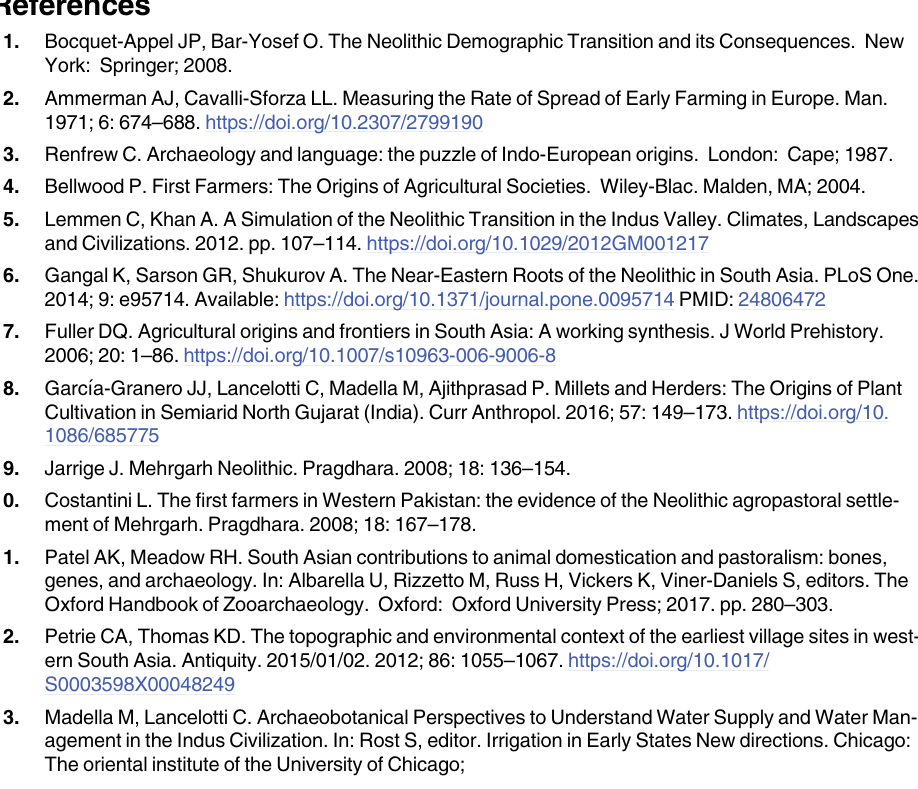
S2 Table. Speeds assigned to each biome (from Mureybet). Speeds assigned to each biome at the end of the genetic algorithm using the site of Mureybet as the origin. S3 Table. Speeds assigned to each biome (from Dhra). Speeds assigned to each biome at the end of the genetic algorithm using the site of Dhra as the